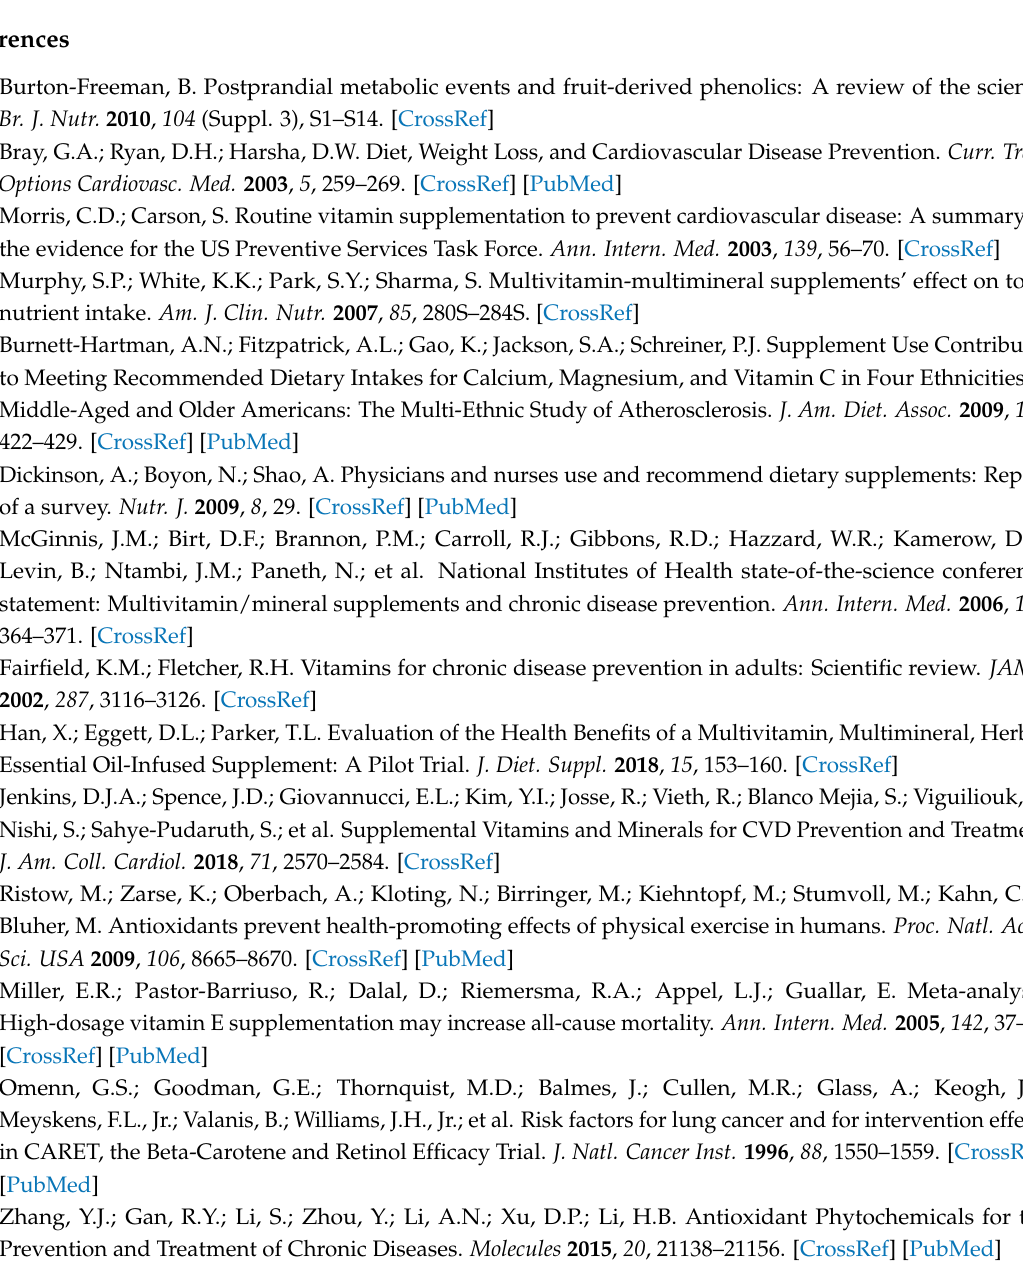
Figure S1: Study design, Table S1: Inclusion and exclusion criteria, Table S2: Genes in PCR array, Table S3: Subjects dietary intake and lifestyles, Table S4: Change in gene expression in PBMC after eight-week supplementation, Table S5: List of top ten pathways changed after eight-week PMP supplementation (gene ontology analysis), Table S6: UPLC-Q-TOF-MS and UHPLC-LTQ-IT-MS/MS identified vitamin and phytonutrients in PMP study product. Author Contributions: Conceptualization, O.K. and J.Y.K.; Methodology, O.K. and J.Y.K.; Formal Analysis,